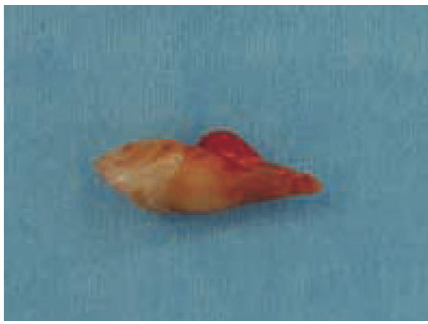
Figure 7: Identified and removed permanent